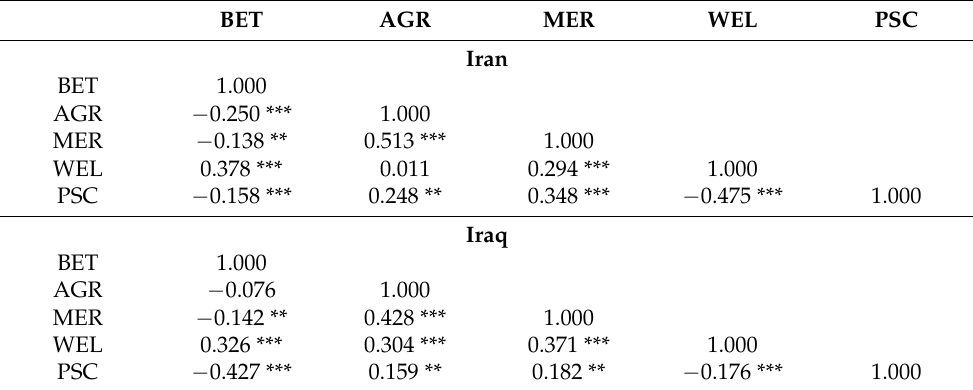
Table 9. The correlation matrix of research components for Iranian